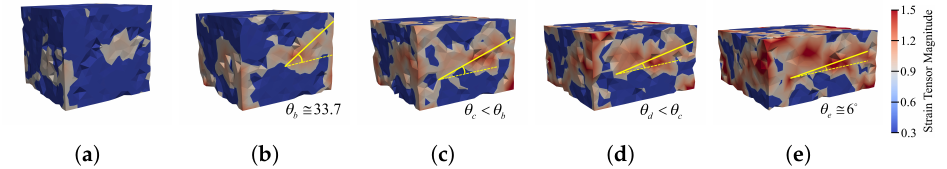
Figure 12. The micro-strain contour evolution during the compaction process of specimen S 4 , ( a ) (cid:101) 3 = 0.1, ( b ) (cid:101) 3 = 0.2, ( c ) (cid:101) 3 = 0.3, ( d ) (cid:101) 3 = 0.4, ( e ) (cid:101) 3 = 0.5.